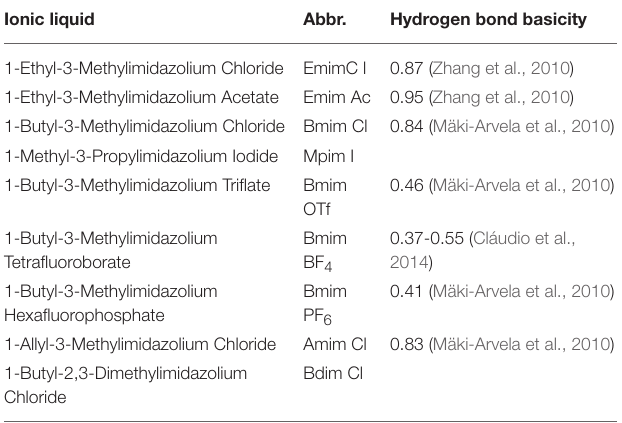
TABLE 1 | Ionic liquids used in the IL screening experiments. Ionic liquid Abbr. Hydrogen bond